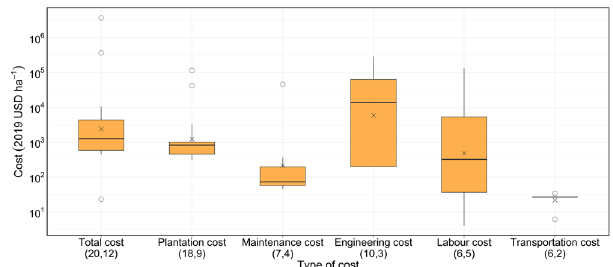
Fig. 4 Range of mangrove restoration costs. The fi rst and second numbers in parentheses indicate, respectively, the number of observations and the number of studies for each cost category. The midlines in box-whisker plots represent the median values and the crosses (×) are the mean values. The bottom and top edges of each box indicate the 25th and 75th percentiles, respectively. The whiskers extend to 1.5 times the interquartile range and outliers are marked using dots. Source data are provided as a Source Data fi